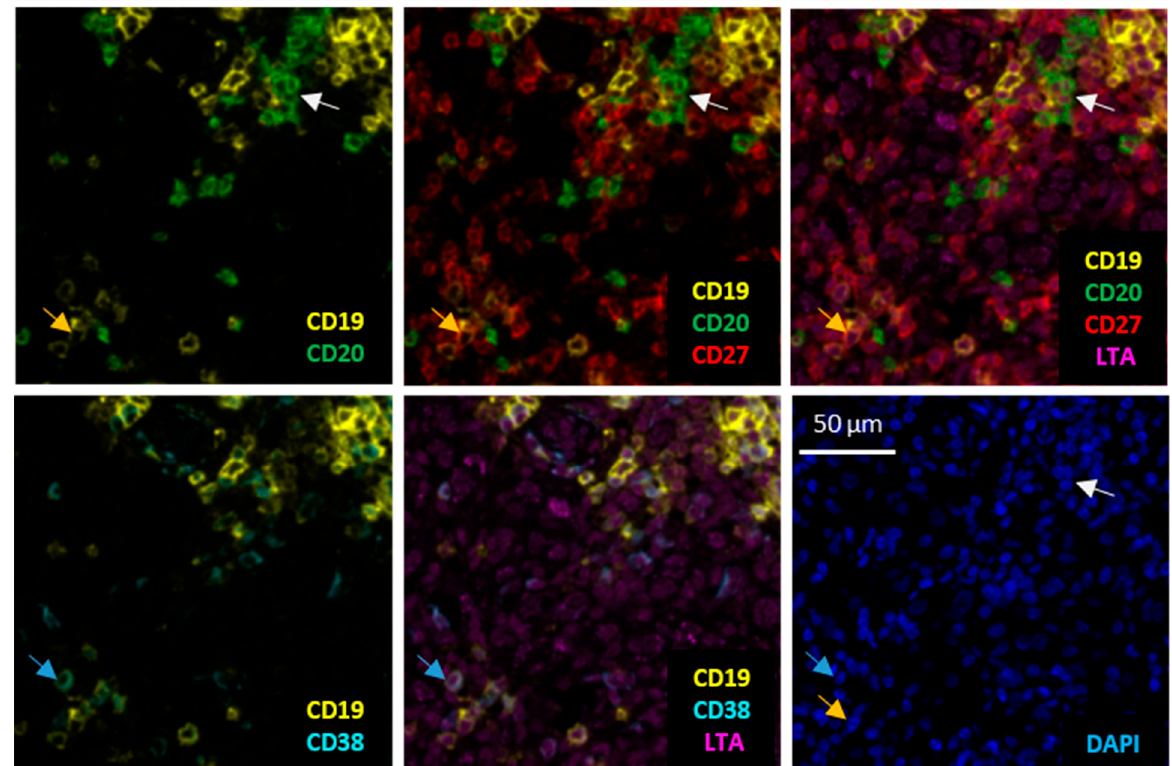
Figure 1. LTA + B cell subpopulations in human melanoma. Identification of a LTA + CD19 + CD20 + CD27 − CD38 − memory- like B cell (white arrow), a LTA + CD19 + CD20 − CD27 + CD38 − activated B cell (yellow arrow) and a LTA + CD19 + CD20 − CD27 − CD38 + antibody secreting cell (blue arrow). Serial images of the same cells for the different cell markers and the cytokines LTA and IL-10 in the two upper rows; composite images for marker combinations are given in the two lower rows, together with respective LTA staining and negative staining for IL-10. DAPI nuclear staining in the lower right. Arrows depict the same cell, being representative of the respective B cell subpopulation. Scale bar represents 50 µm.